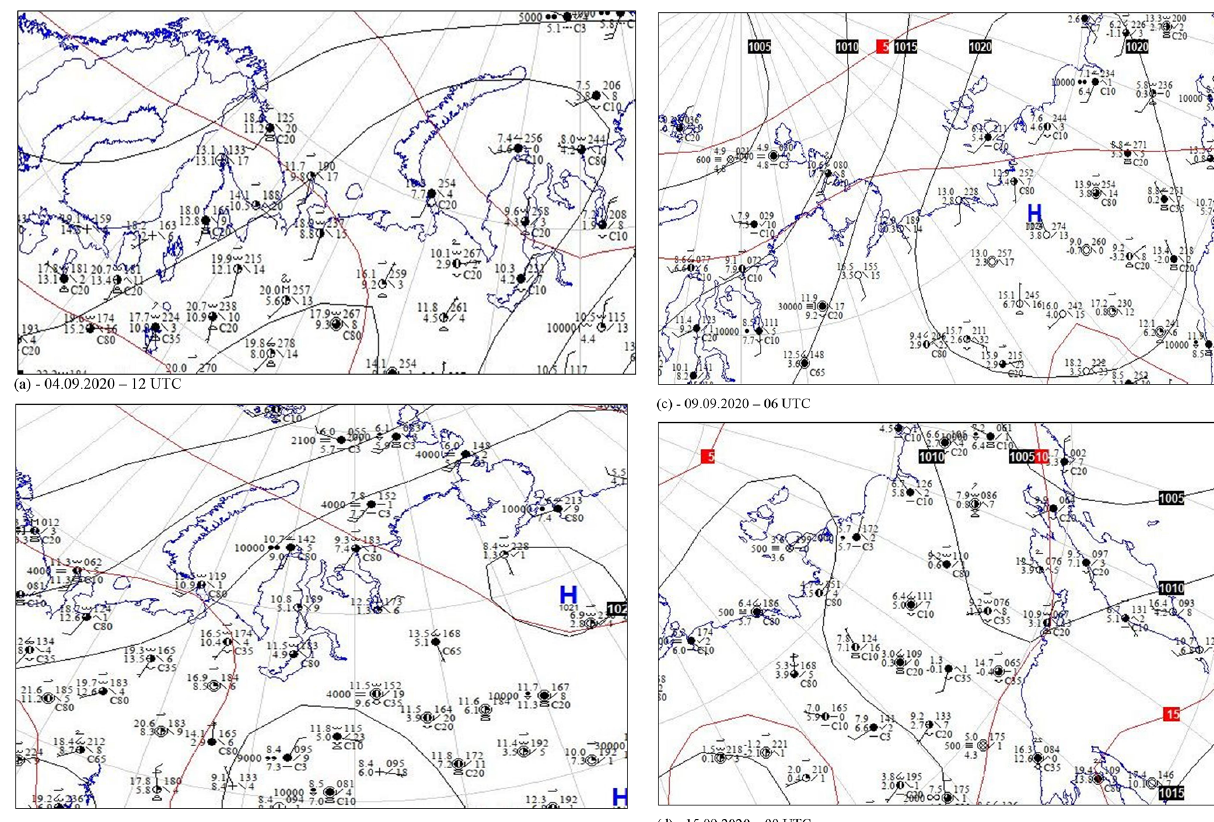
Figure 6. Surface weather maps for 4–17 September 2020. UTC time and date are given in the appropriate box.